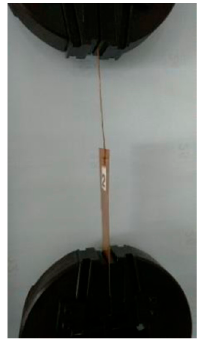
Figure 2. Tensile loading.